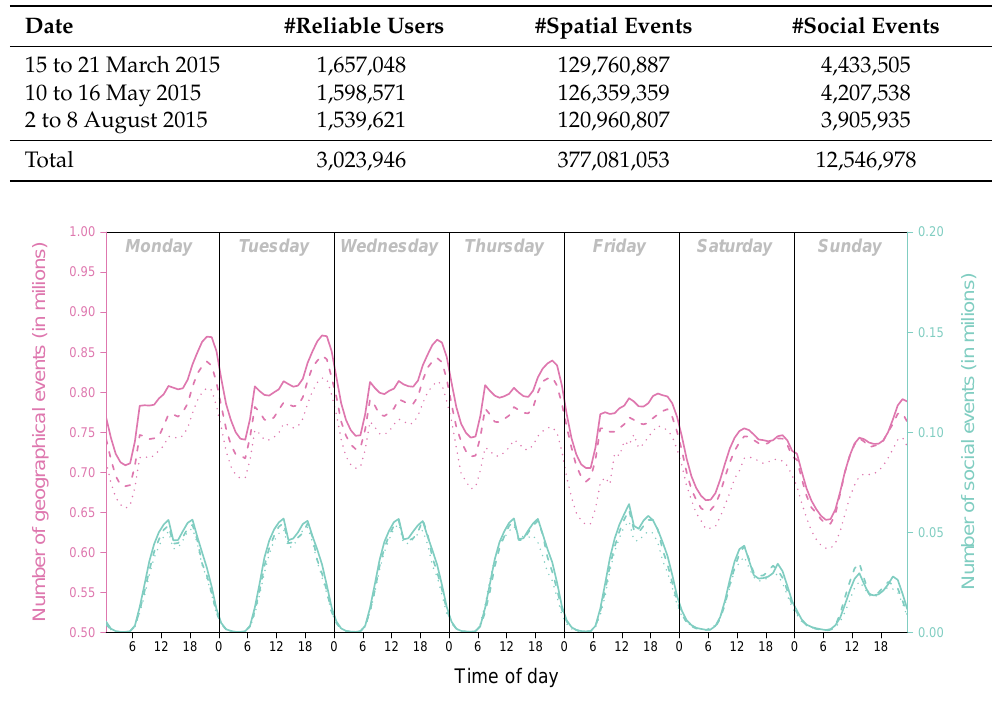
Figure A4. Number of spatial events (in pink) and social events (in green) according to the hour of the day. Each line represents a week of